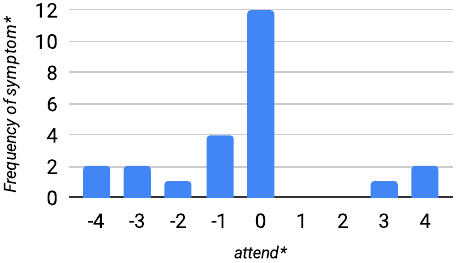
Fig. 6 Distribution of lemma of SYMPTOM with respect to conjugations of verb at node = 0. Verb attend with symptom in English core corpus, standard deviation form mean, μ = − 0.75, σ = 3.92). Starred items denote noun and verb forms rather than